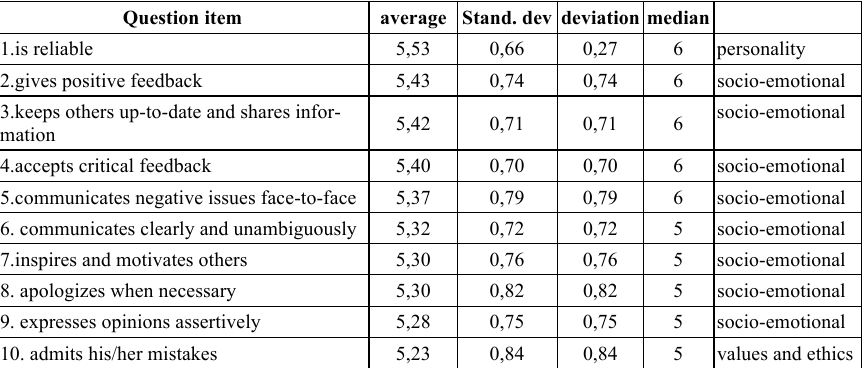
Top ten item averages in the sample Question item average Stand. dev deviation